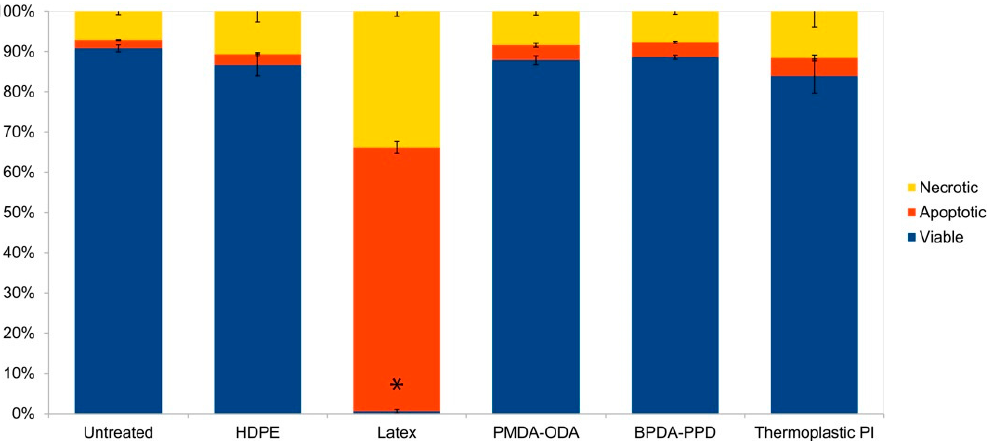
Figure 4. Cell viability of SV-HCEC human endothelial cells after 24 h exposure (Polyimide (PI) samples in cell culture media at 37 °C for 48 h, 1 cm 2 /mL media ratio) to extracts coming from various common PIs: PMDA-ODA (Kapton), BPDA-PPD (thermally imidized PI2611 precursor), and polyimidic adhesive (thermally imidized HD3007 precursor). Negative controls: untreated cells, high-density polyethylene (HDPE). Positive control: natural latex rubber. Reproduced from [30], with permission from © 2015 John Wiley and Sons.